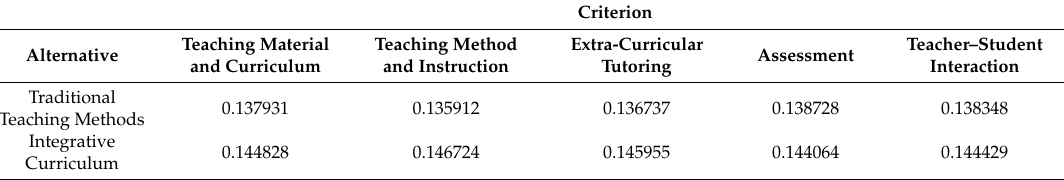
Table A2. The weighted normalized decision